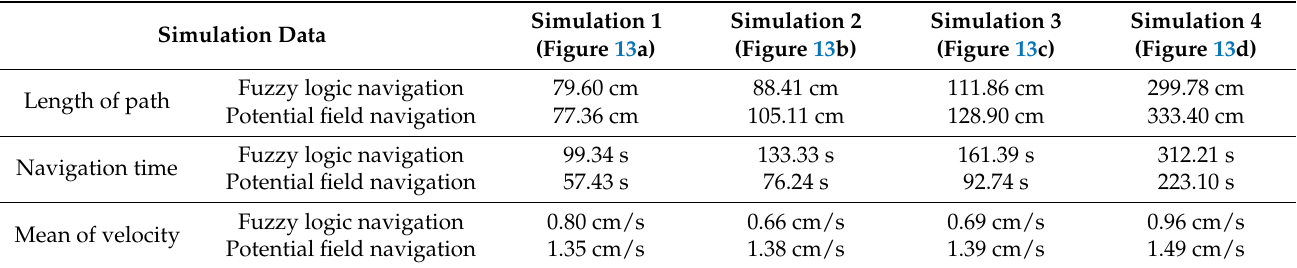
Table 4. Rules for avoiding obstacles in robot